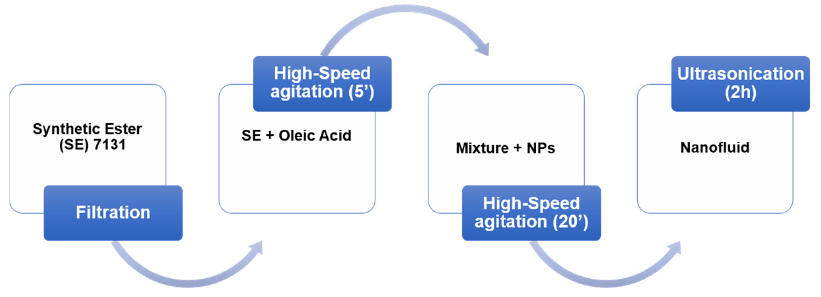
Figure 1. The preparation procedure of nanofluids (NFs).